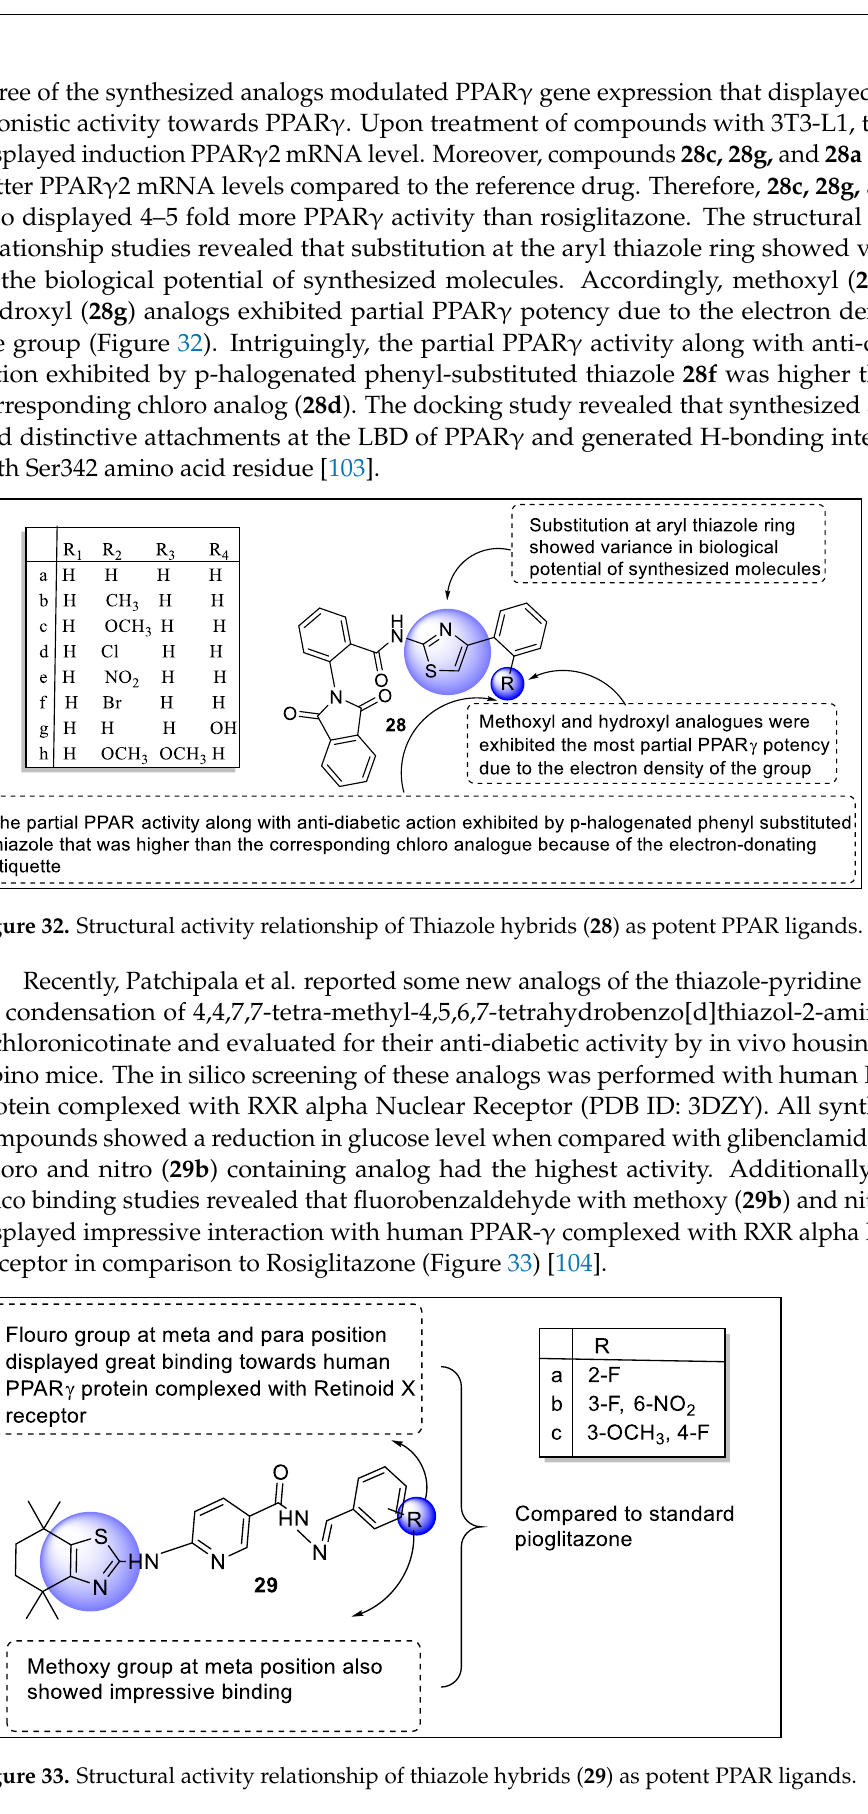
Figure 31. Structural activity relationship of thiazole hybrids ( 27 ) as potent PPAR ligands.